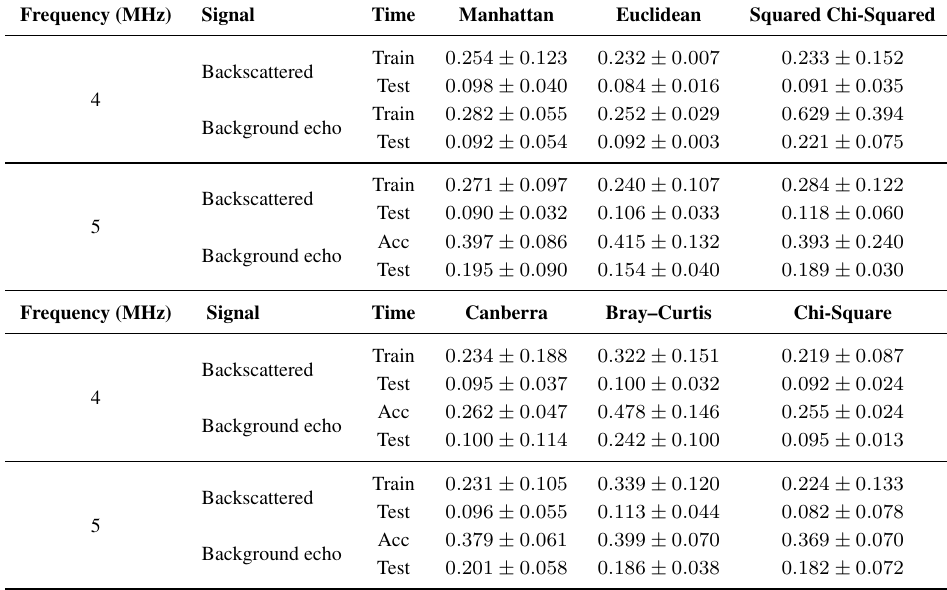
Table 12. Average of training and testing times in milliseconds for the 4- and 5-MHz frequency signals at 950 ◦